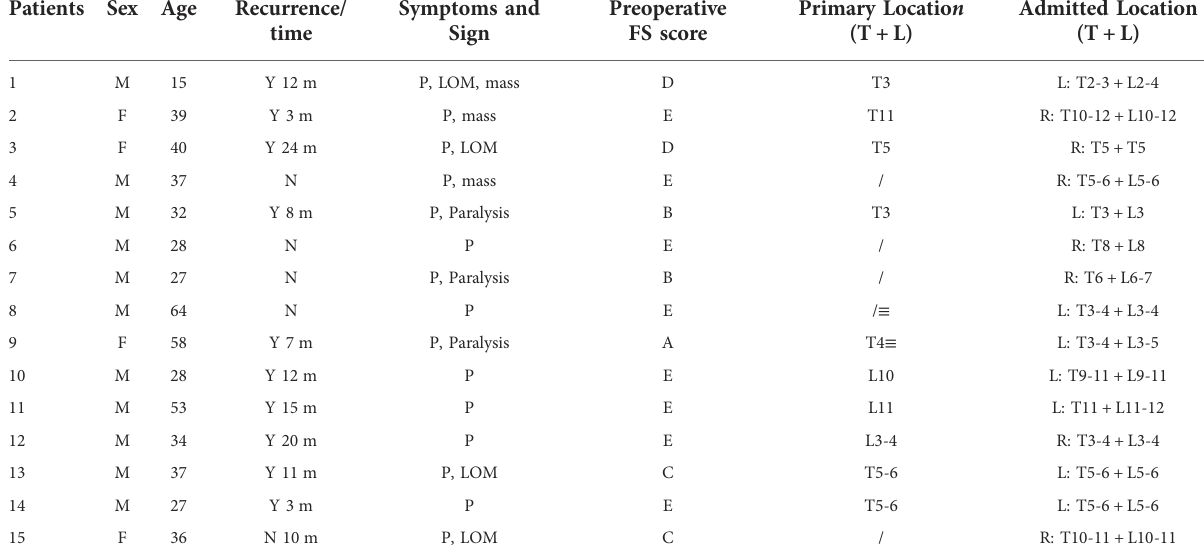
TABLE 1 Clinical data of a series of included patients. Patients Sex Age